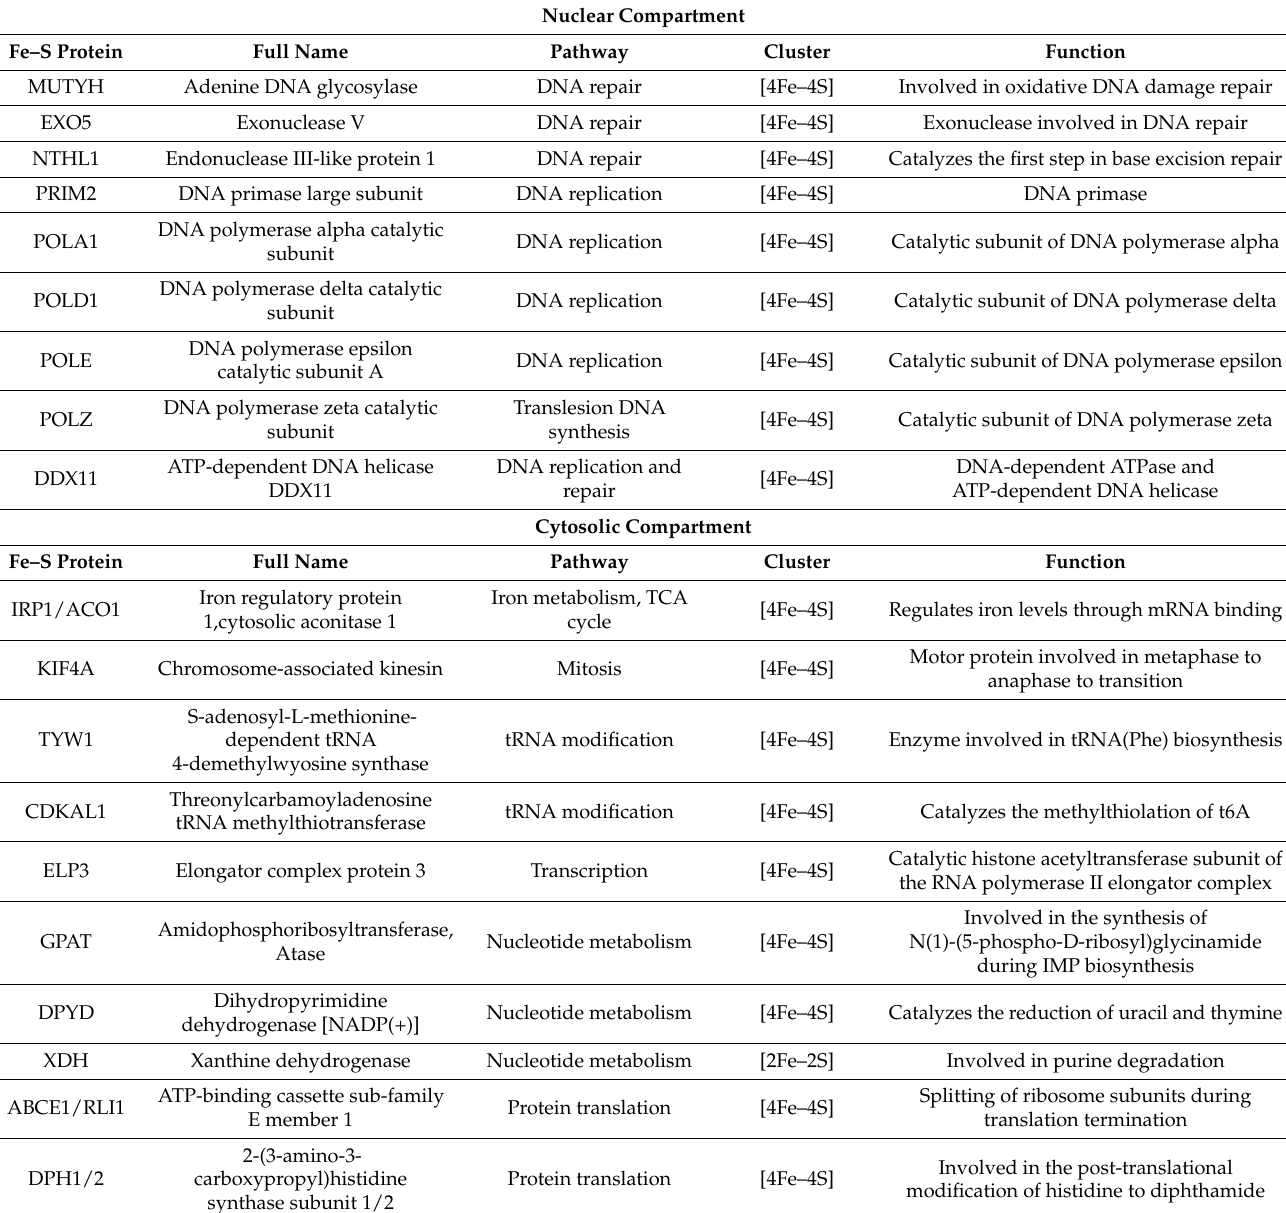
Table 2. Fe–S client proteins found in the human nucleus and